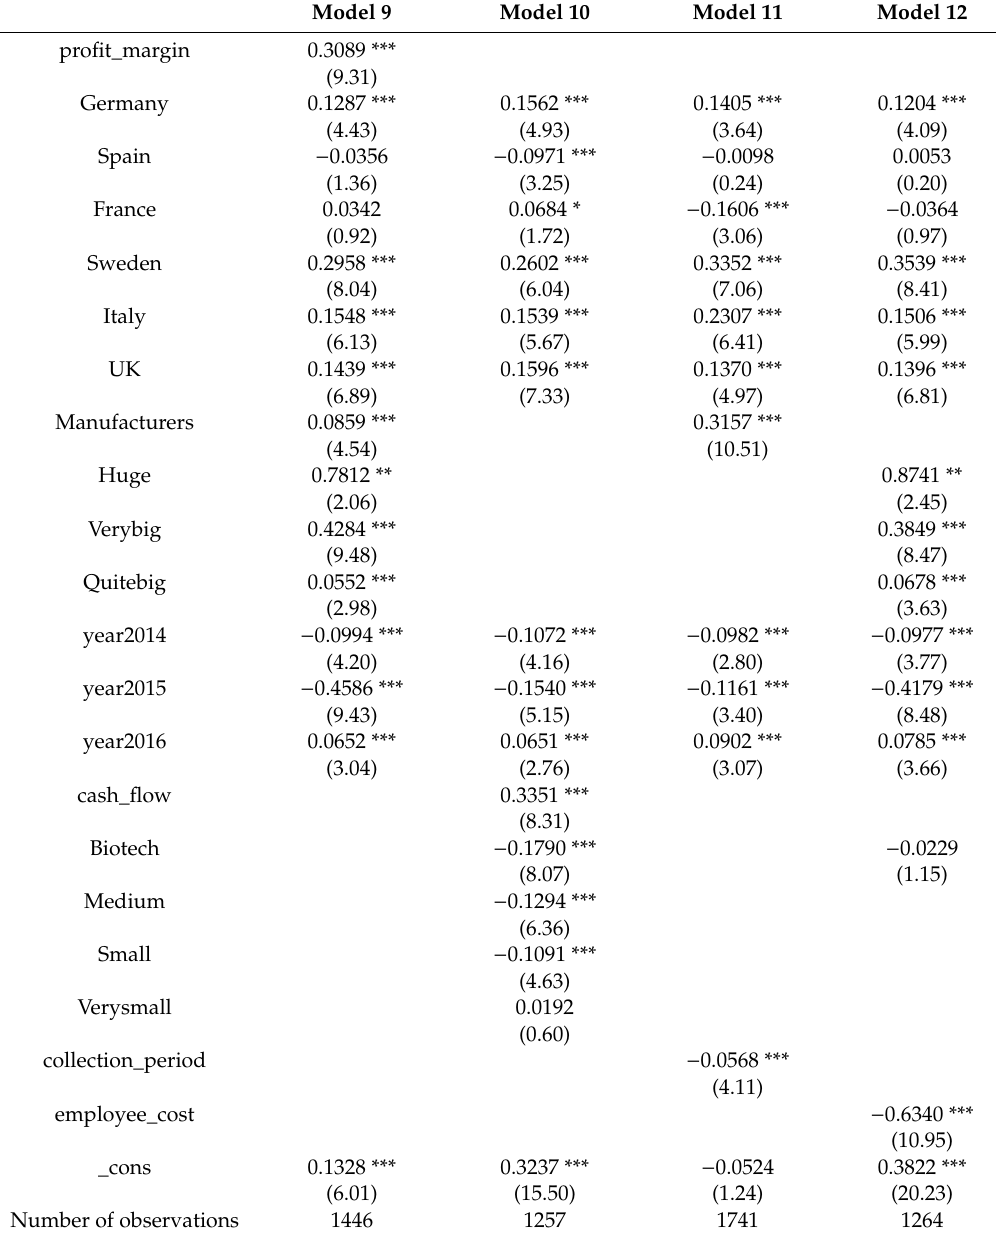
Table 6. Variables correlated with e ffi ciency, Simar–Wilson estimations. Dependent variable is e ffi